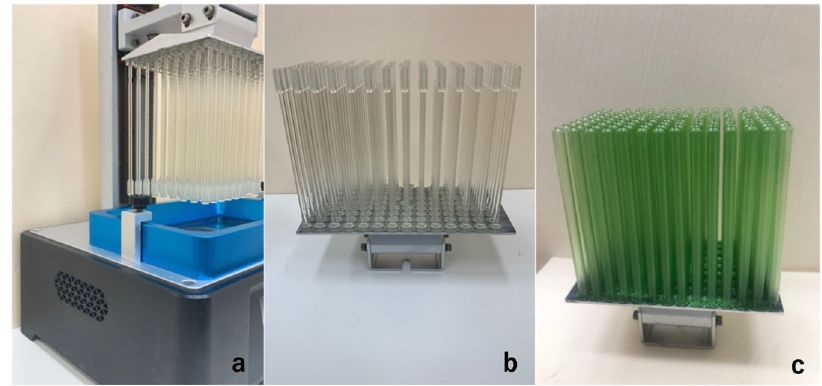
Fig. 7 Practical production photos. a Printing process. b Printing result of the swabs.